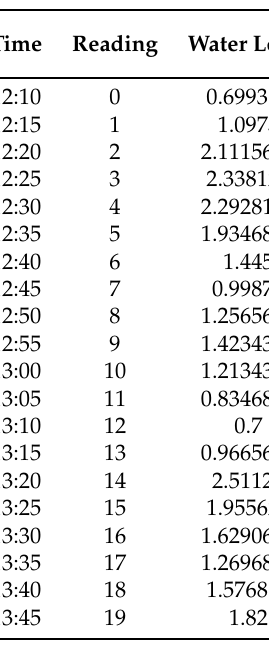
Table 7. Sequence of 20 rows of the data set with the system status